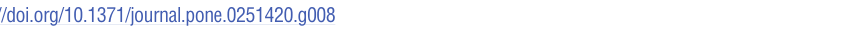
Fig 8. Average shear strength at the reference sites. (a) Short- and (b) tall-form S . alterniflora sites. Shaded regions represent ± 1 SD.